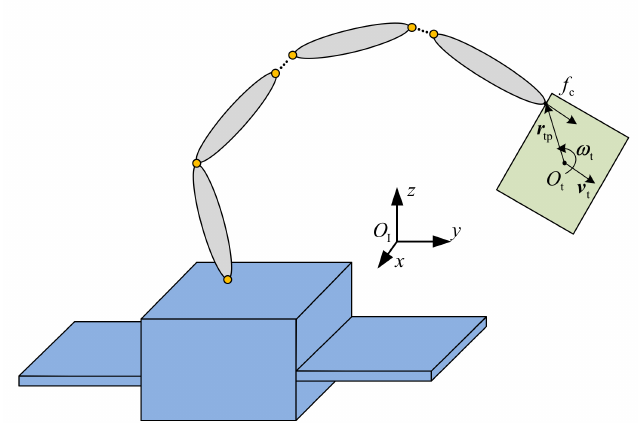
Figure 1. Free-floating space robot capturing a tumbling